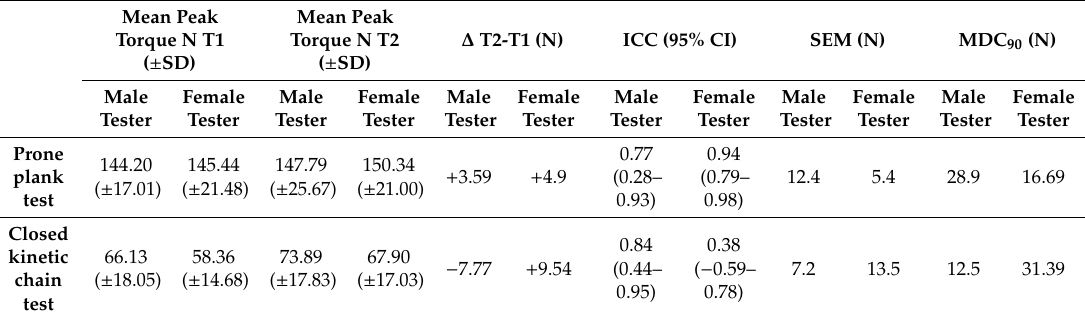
Table 3. Intratester intersession reliability results (T1) for both tester (N = 22). N = Newton; SD = standard deviation; ICC = intraclass correlation coe ffi cient; SEM = standard error of measurement; MDC 90 = minimal detectable change 90% confidence level.